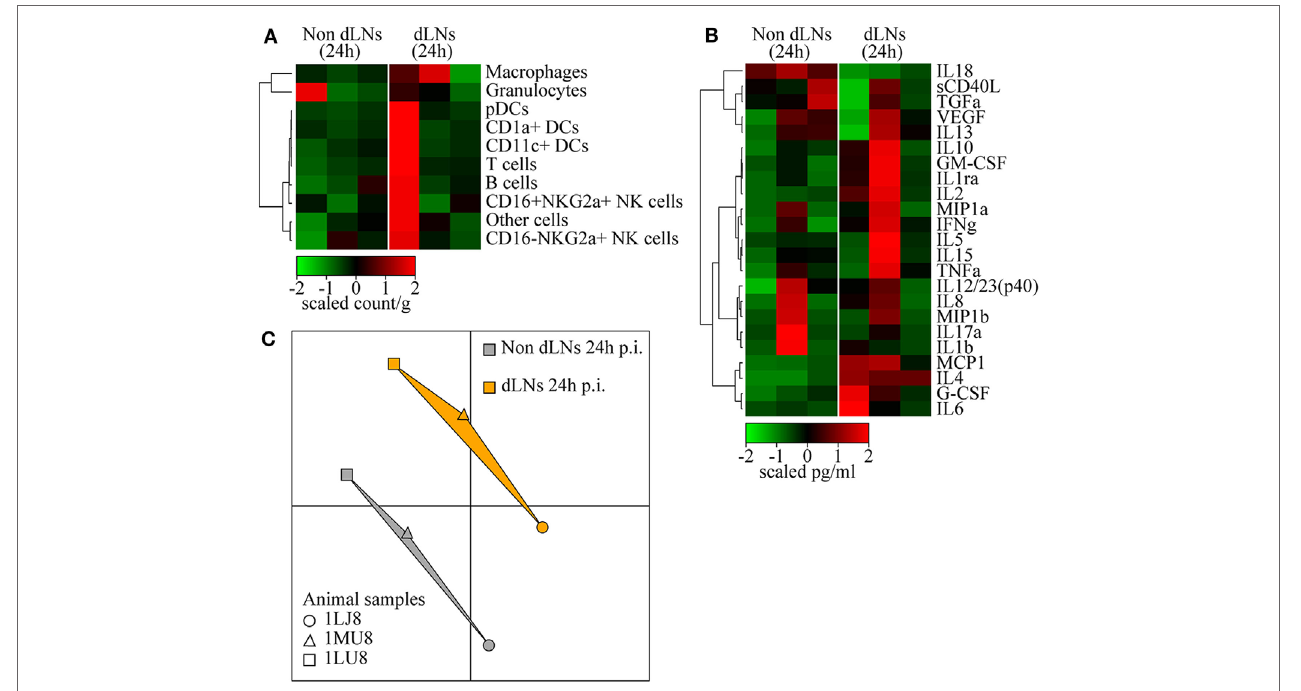
FigUre 4 | Immune reaction in the draining lymph nodes (LNs). (a) Heatmap representation of cell populations discriminated by flow cytometry in the inguinal LNs draining the sites of rMVA injection (dLNs) and the contralateral LNs (Non dLNs). Cell populations were automatically sorted following hierarchical clustering represented by the dendrogram on the left. The cell count/gram was calculated by dividing the number of events by the weight of the biopsies, which were collected 24 h p.i. Values were standardized to display the same range of expression values for each cell population to properly visualize the cell population kinetics. See Figure S3B in Supplementary Material for gating strategies. (B) Heatmap representation of cytokine release in the LNs after rMVA injection. Cytokine production was automatically sorted following hierarchical clustering represented by the dendrogram. Values were standardized to display the similar range of expression for each cytokine to properly visualize the cytokine production kinetics. (c) Multidimensional scaling representation of transcriptomic signatures in LNs 24 h after rMVA injection. Biological samples are represented as dots in a two-dimensional space. The distances between the dots are proportional to the Euclidian distances between the transcriptomic